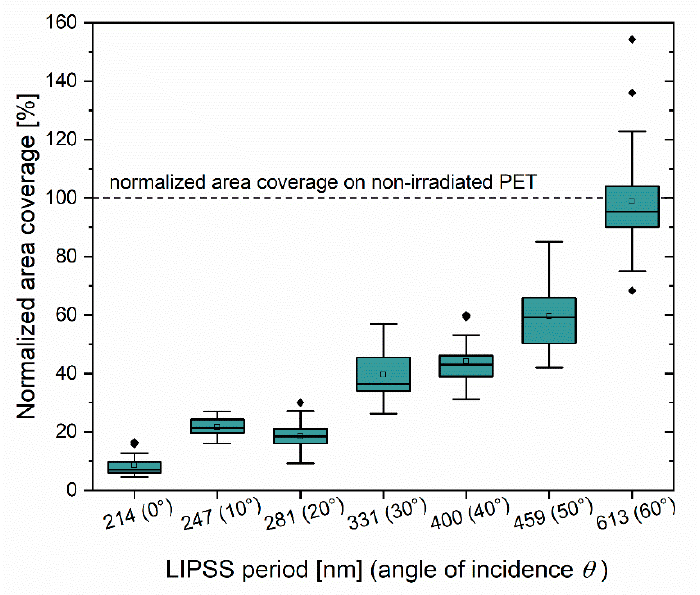
Figure 6. Surface area of laser-irradiated PET covered by E. coli TG1 cells normalized against non-irradiated (flat) control surface. Data were obtained through analysis of 25 micrographs of biofilms on laser-irradiated PET and the same number of micrographs of biofilms formed on non-irradiated PET of the same PET foil. The box-whisker plots present 25th and 75th percentiles within the box along with mean (open symbol) and median (continuous line) values, 1.5 interquartile range whiskers, and statistical outliers (closed symbols). All experiments were repeated at least three times for each value of θ with different PET samples and the graph displays representative results.